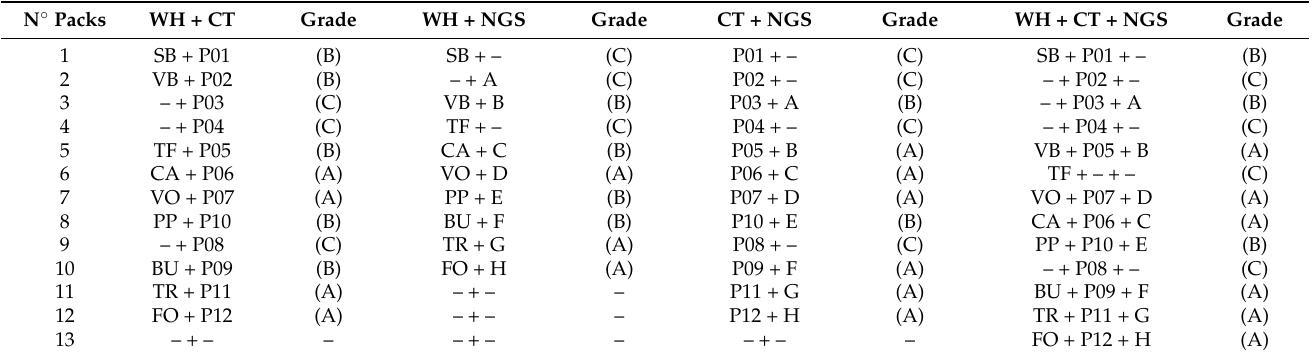
Table 6. Packs identified by integrated methods. Packs’ IDs with two letters are from WH; packs’ IDs with P plus a number are from CT; packs’ IDs with one letter are from